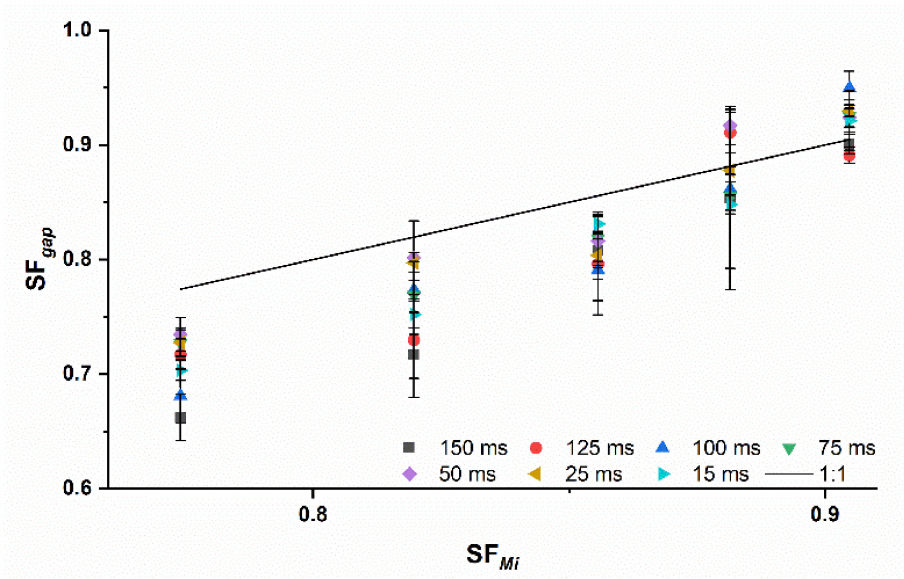
Figure 6. Measured SF gap off lactose ribbons with changing dwell times compared to the predicted ribbon solid fraction of the Midoux number SF Mi (solid black line); x ± s ; n =